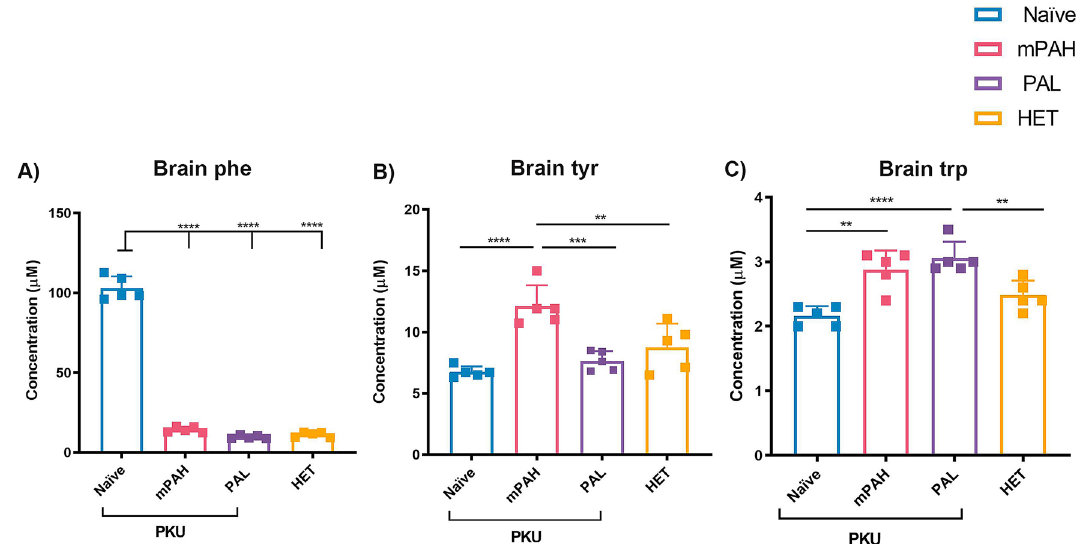
Figure 2. Brain amino acid levels post PAH or PAL administration. (A) Brain Phe is reduced to normal levels in PAH or PAL treated PAH enu2 mice. (B) Brain Tyr levels are restored to normal in PAH PAH enu2 mice but not in PAL PAH enu2 mice. (C) Brain Trp is increased in both PAH and PAL treated PAH enu2 mice. N = 5 per group were used for analysis. Control mice and mice treated with 1e11 vg/mouse of PAH or PAL vector were terminated on day 41 and perfused with PBS. Naïve untreated PAH enu2 mice, PAH or PAL , treated PAH enu2 mice, HET untreated HET mice. One-way ANOVA Tukey’s multiple comparison, **p < 0.01 and ****p <